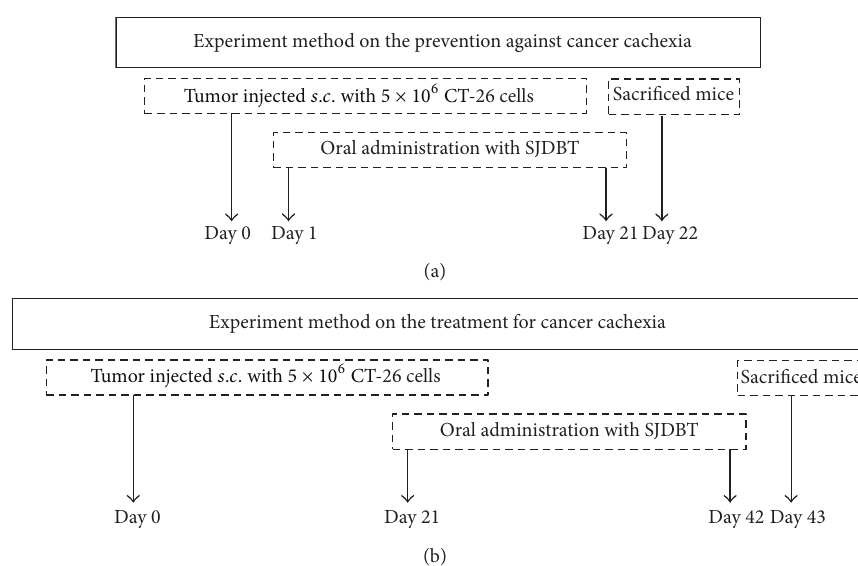
Figure 1: Schedules for prevention and therapy models of mouse cancer-induced cachexia. 5 × 10 6 CT-26 tumor cells were subcutaneously ( s.c. ) injected into the right flank of BALB/c mice. (a) Experiment method on the prevention: a day after tumor cell inoculation, three doses of SJDBT (L-SJDBT of 6.784 mg/kg, M-SJDBT of 67.84 mg/kg, and H-SJDBT of 678.4 mg/kg) were p.o. administrated daily for 21 days. At 22 days after tumor cell injection, mice were sacrificed. (b) Experiment method on the therapy: 21 days after tumor cell inoculation (a day when cachexia was held), three different doses of SJDBT (L-SJDBT of 6.784 mg/kg, M-SJDBT of 67.84 mg/kg, and H-SJDBT of 678.4 mg/kg) were p.o. administrated daily for 21 days. At the end of experiments (42 days after tumor cell injection), mice were